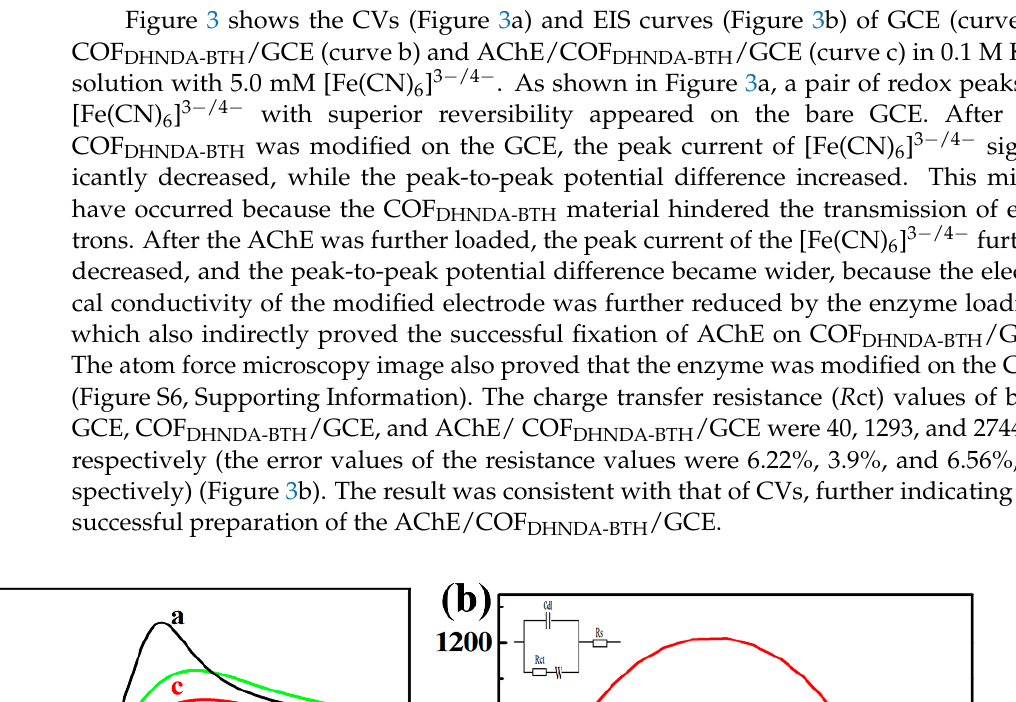
Figure 2. ( a ) Low-resolution and ( b ) high-resolution SEM image of commercial carbon paper.